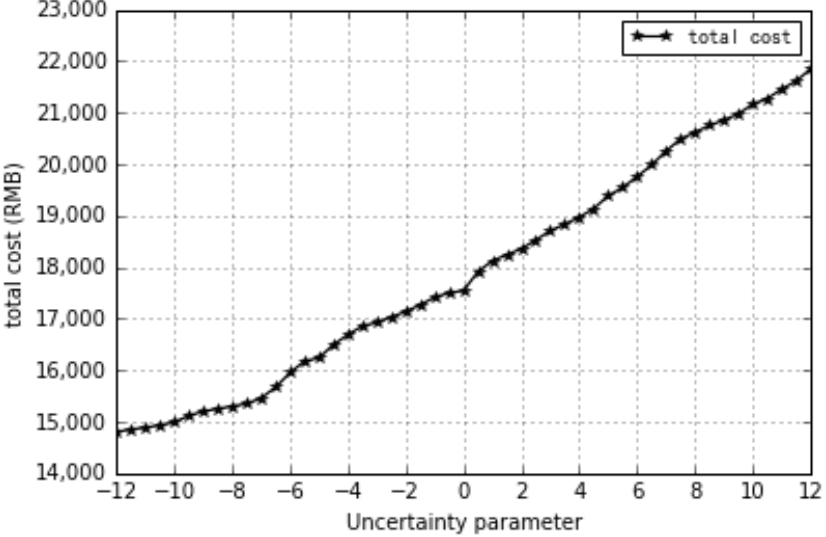
Figure 9. Economic changes in the ARO parameter. Energies 2018 , 11 , x FOR PEER REVIEW